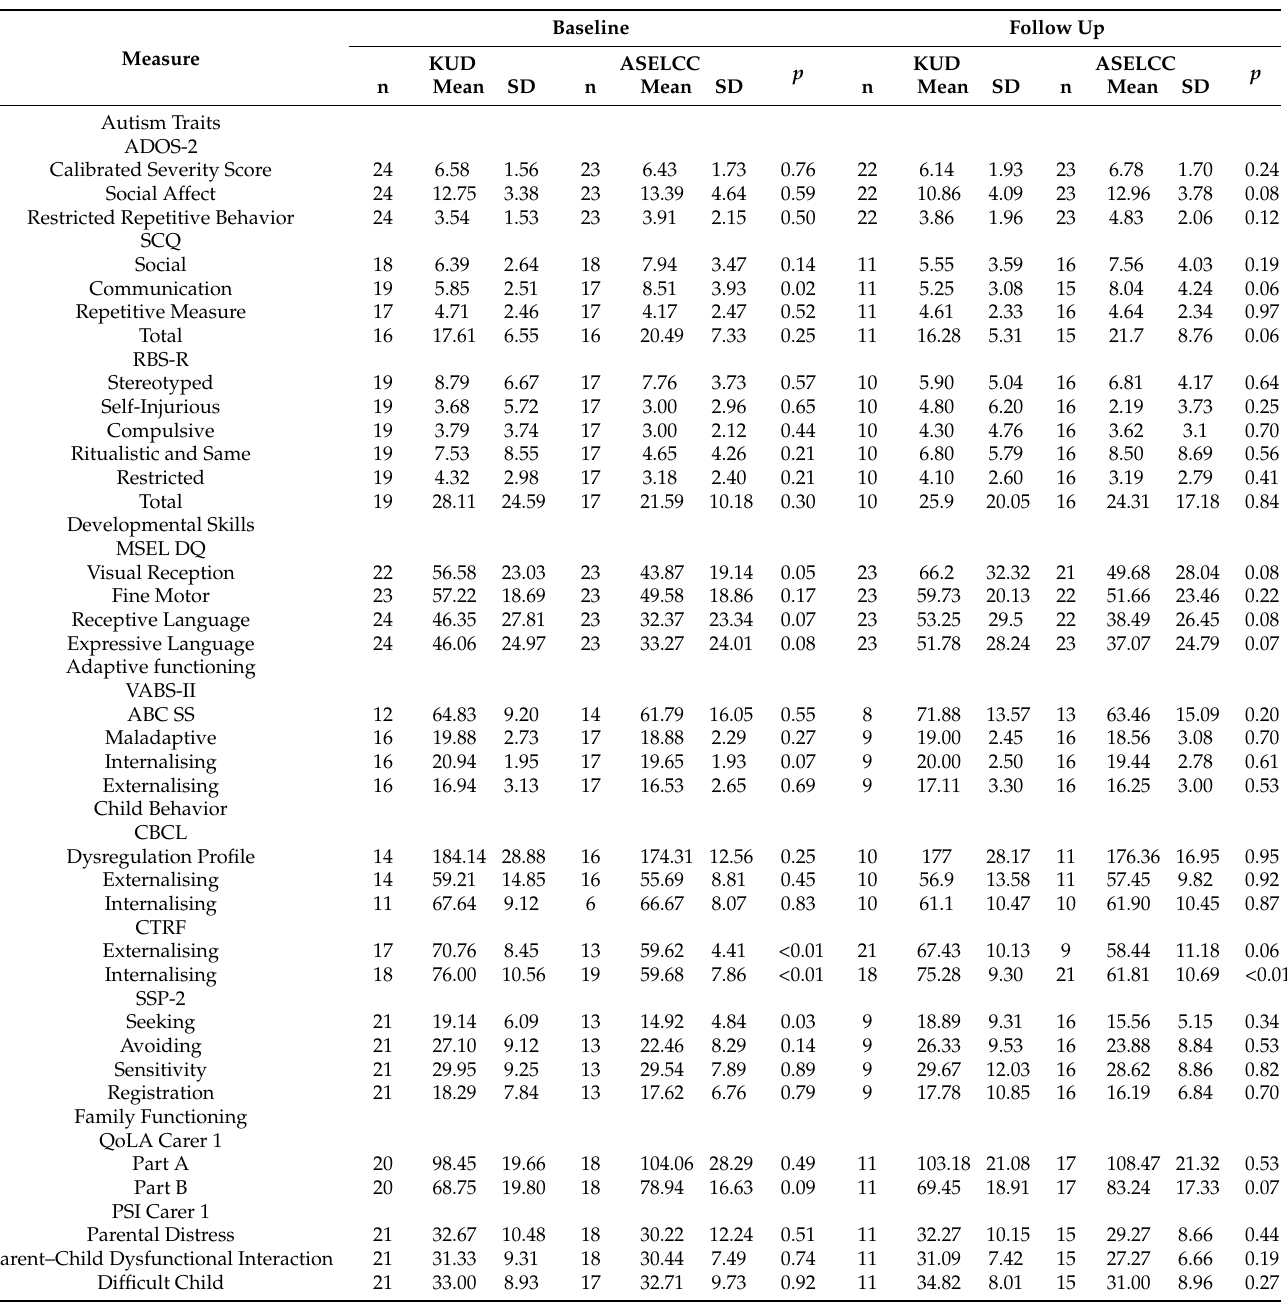
Table 3. Mean scores at baseline and follow